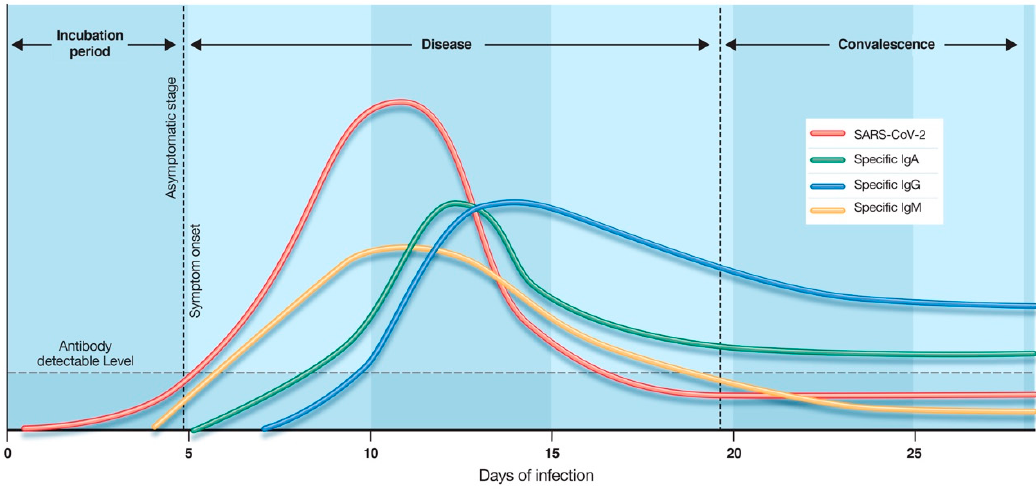
Figure 4. Time kinetics of antibody response in coronavirus disease 2019 (COVID-19). The illustration demonstrates the relative levels of host immunoglobulins (IgM, IgG, IgA) and SARS-CoV-2 viral load at di ff erent stages of COVID-19. Antibody-specific seroconversion occurs when the antibody reaches a detectable level in blood. Disclaimer: This graphic is for illustrative purposes only and does not represent actual levels of each antibody.